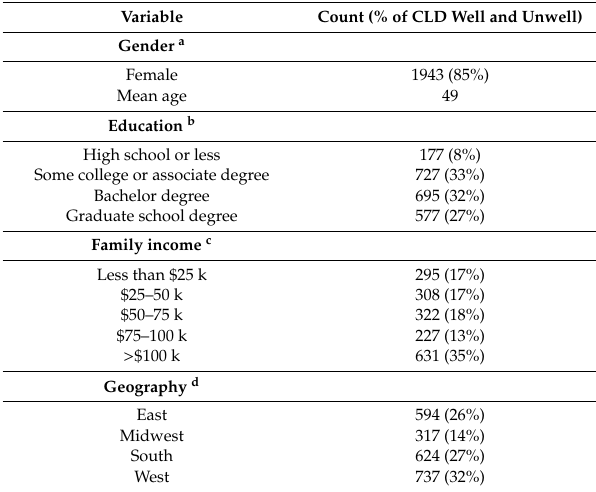
Table 2. Demographic characteristics of